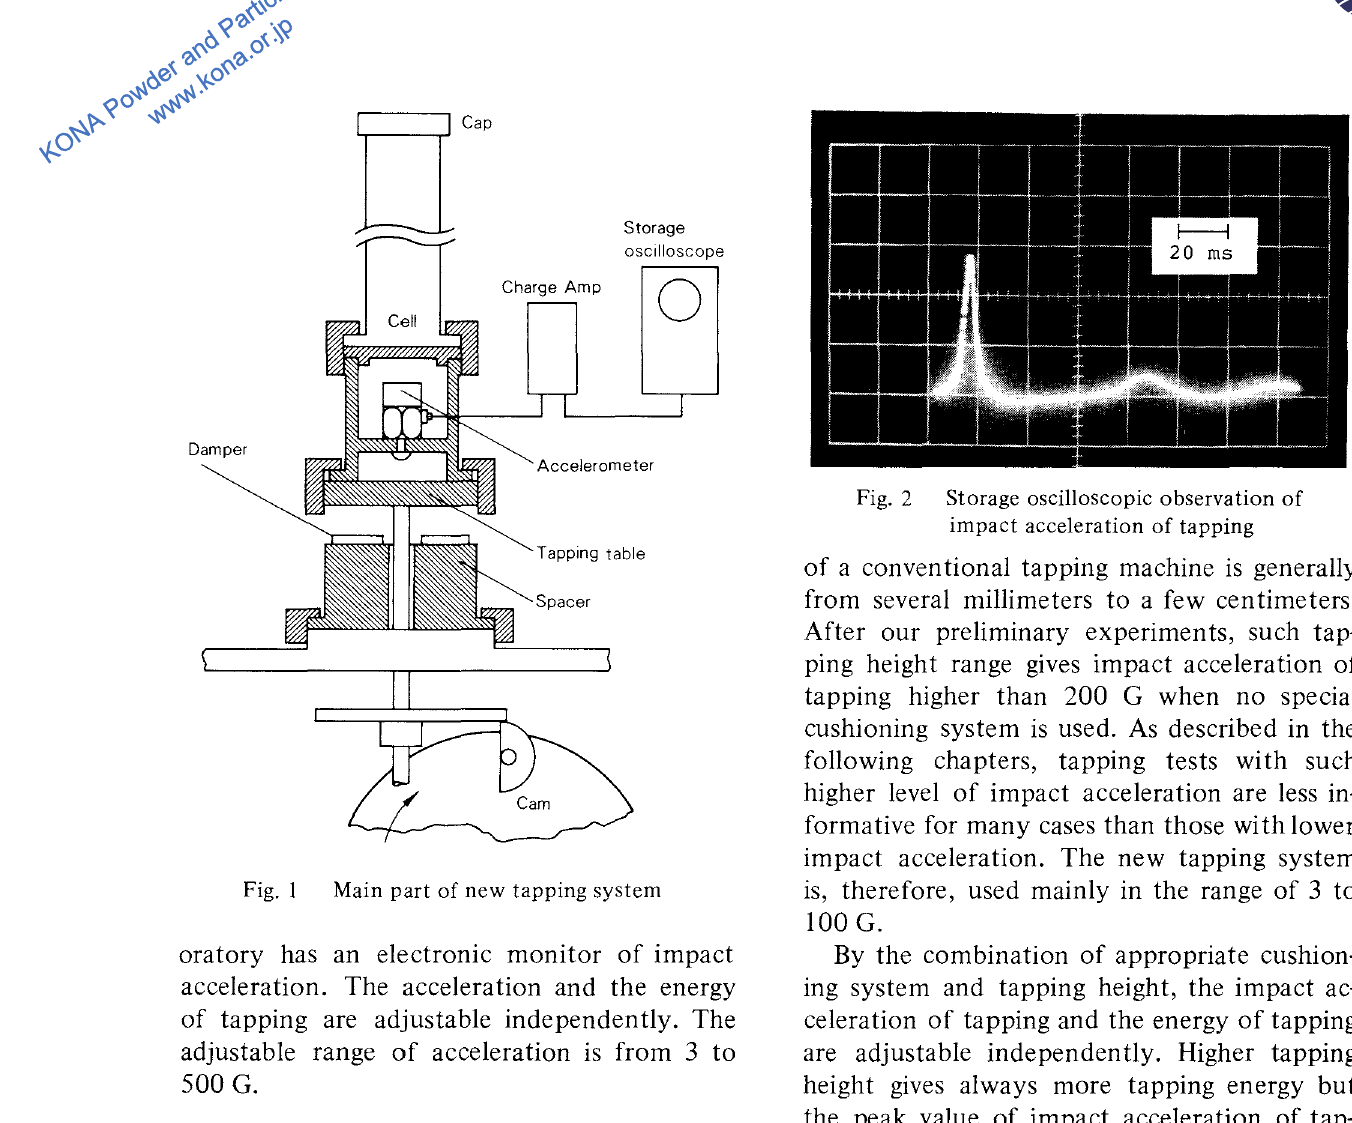
Fig. 2 Storage oscilloscopic observation of impact acceleration of